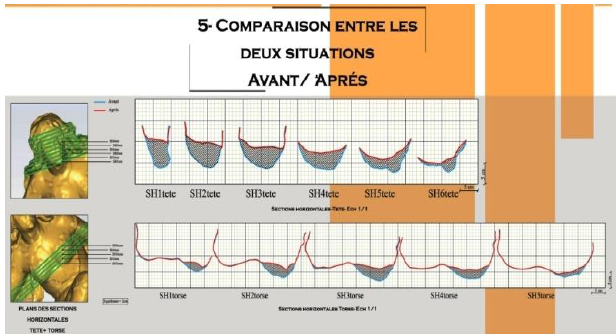
Figure 5. Some results of deterioration of the head and chest of the